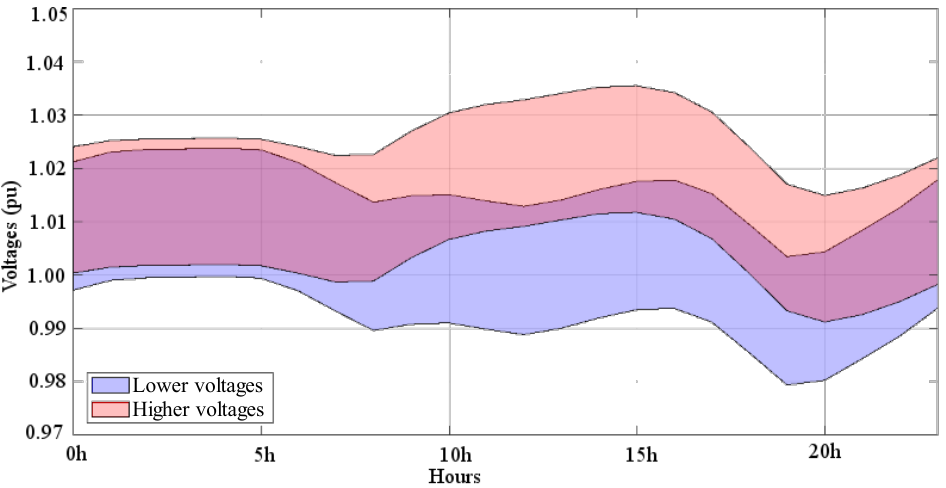
Figure 8. Higher and lower voltages along the